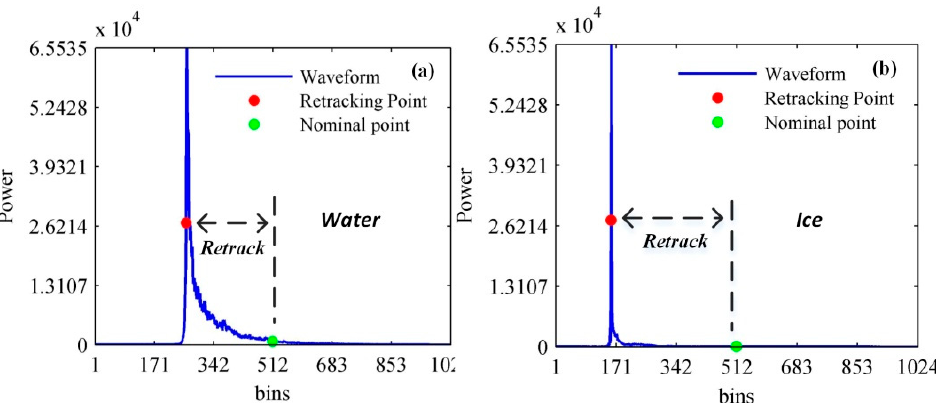
Figure 2. ( a ) Water surface waveform and ( b ) ice surface waveform. Green and red points mark the nominal tracking and retracking points, respectively.